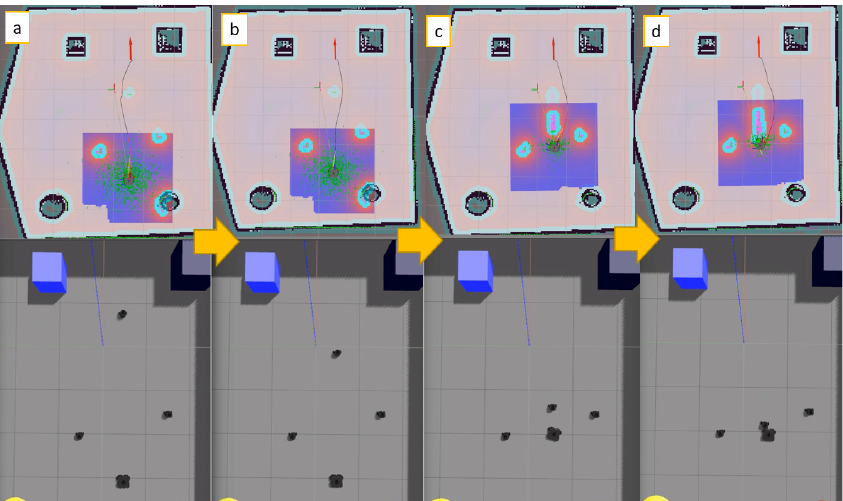
Figure 14. The subfigures ( a – d ) illustrate the obstacle avoidance process of the robot in the cost map layer, the upper part of which shows the visualization tool, and the lower part shows the simulated environment.